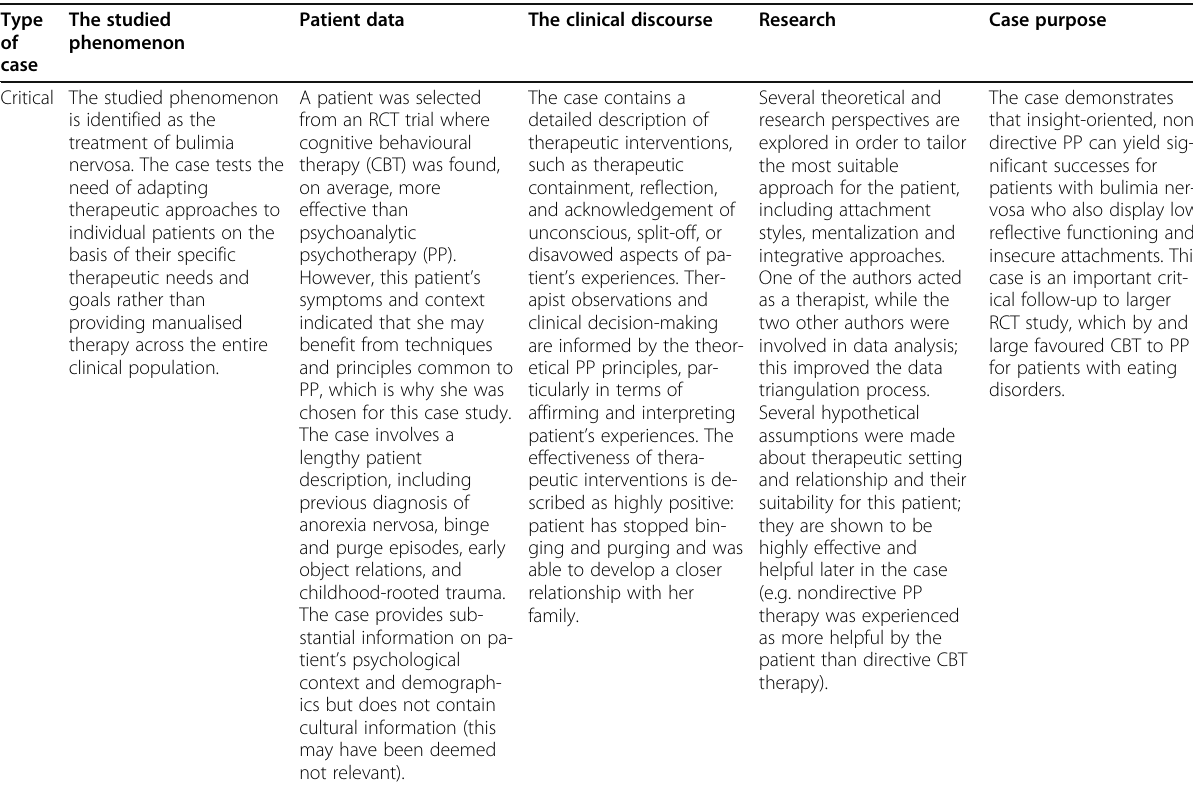
Table 14 Using Case Study Evaluation-tool (CaSE): Lunn et al. (2016) ’ s case ‘ Psychoanalytic psychotherapy with a client with bulimia nervosa